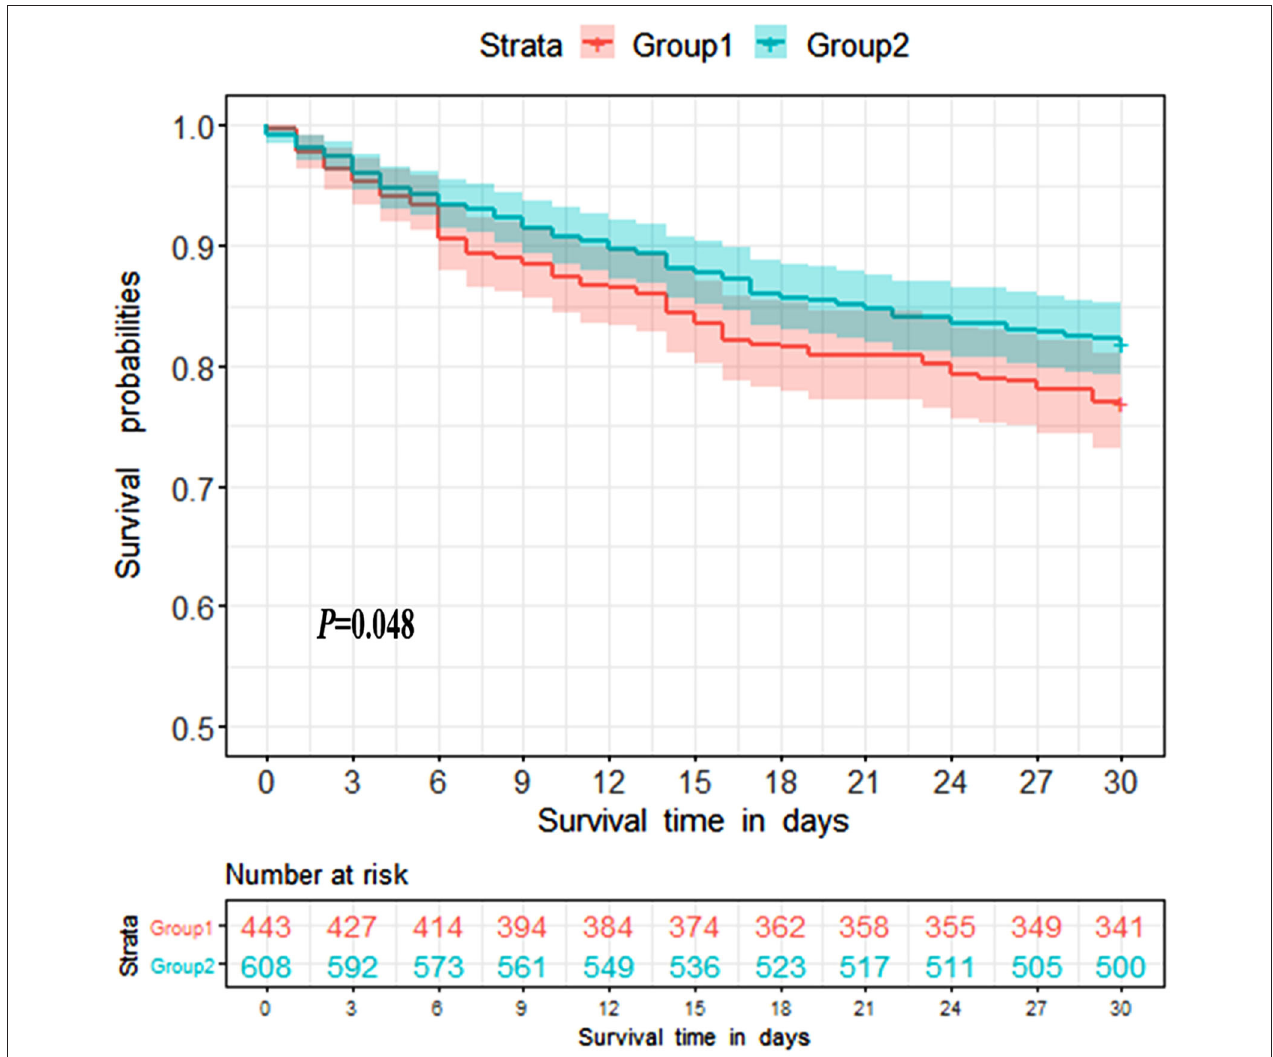
FIGURE 2 | Kaplan-Meier 30 day survival curves for patients without liver disease. Group1 = Hyperammonemia group, Group2 = Non-hyperammonemia